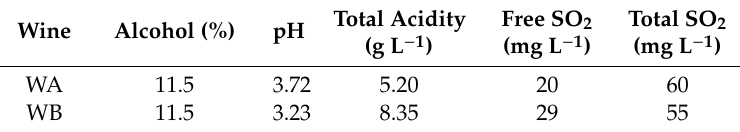
Table 1. Chemical properties of selected red wines.